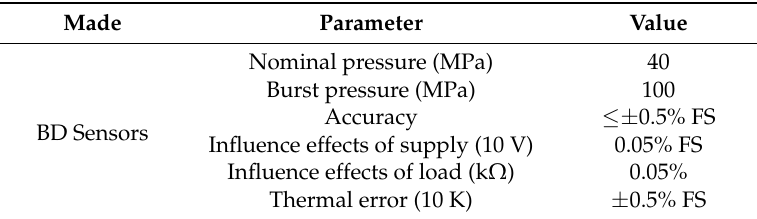
Table 1. The main parameters of the pressure transducer of DMK 331P.